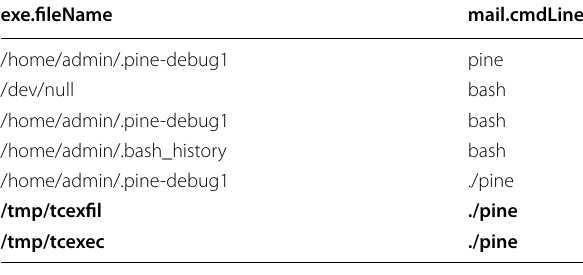
Table 3 Mail clients writing to disk